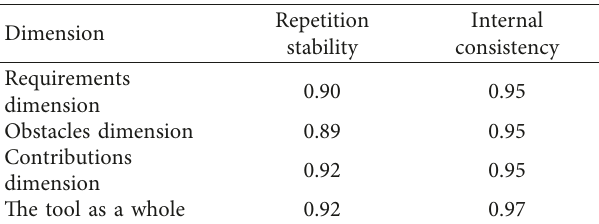
Table 4: Cronbach’s alpha, dimension repetition stability, and questionnaire